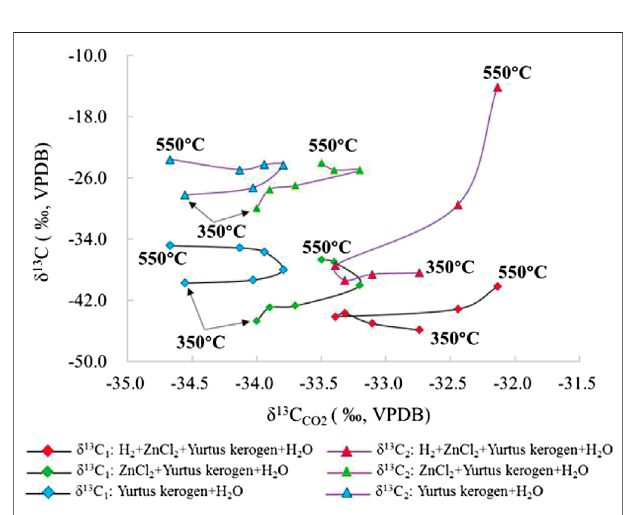
FIGURE 11 | Change in the δ 13 C values of different alkanes and CO 2 under the simulated ZnCl 2 catalyzed hydrogenation control condition of the closed system.